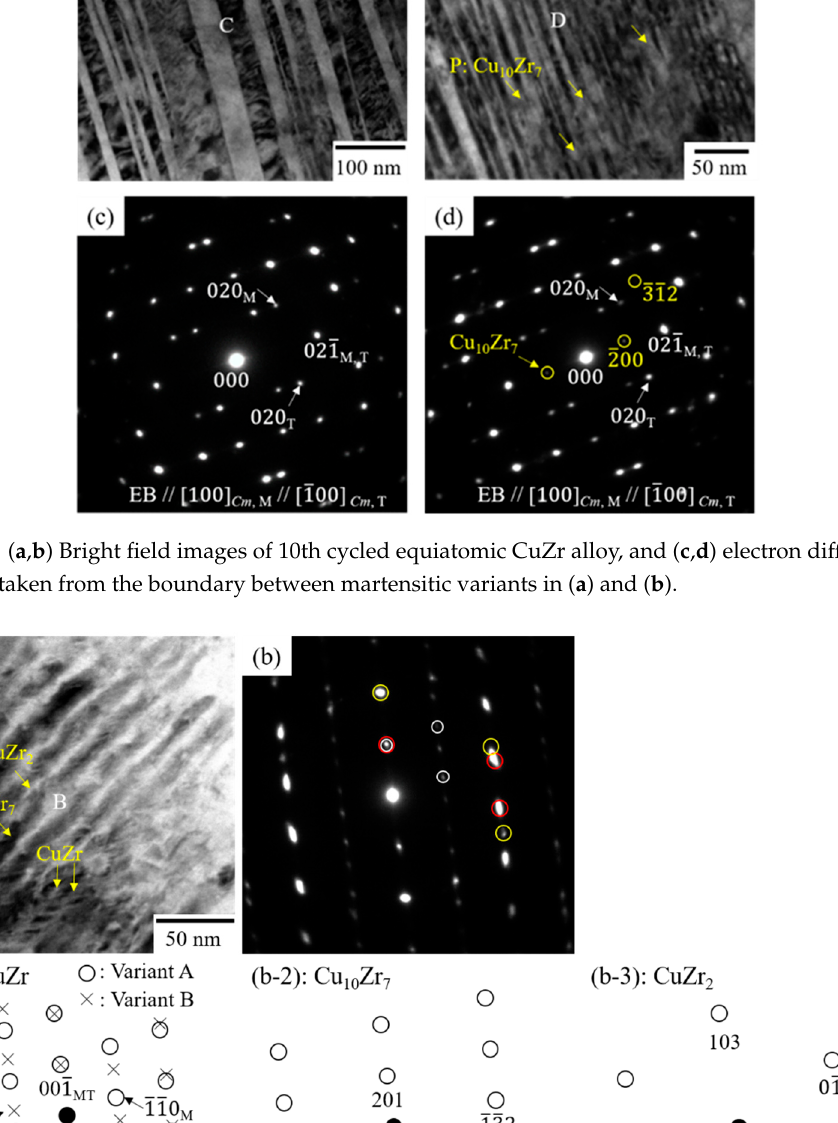
Figure 2. DSC cooling and heating curves of water-quenched equiatomic CuZr alloy from the first to 10th thermal cycles. (Measured max temperature—400 °C).